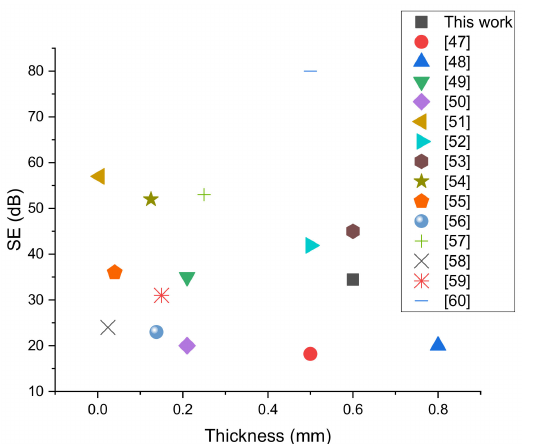
Figure 10. Comparison with reported SE in the literature for polymer composites with thickness less than 1 mm at frequency between 8 to 12